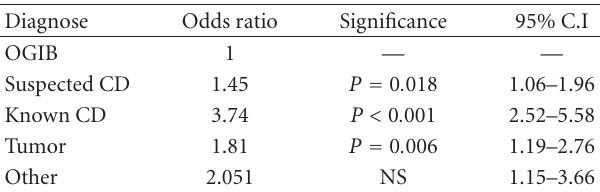
Table 1: Odds ratio of obtaining an incomplete CE for di ff erent indications (adjusted for age and